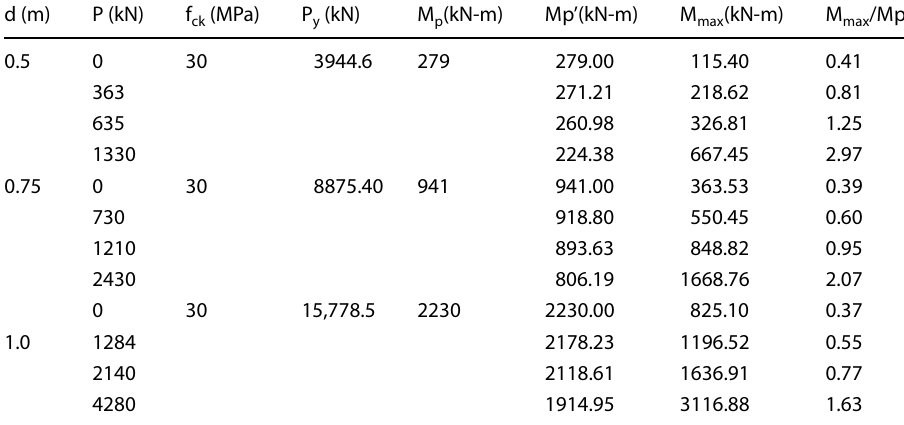
Table 8 Checking against bending failure mechanism of various diameter pile of M-30 grade in RCD soil under scaled IMV